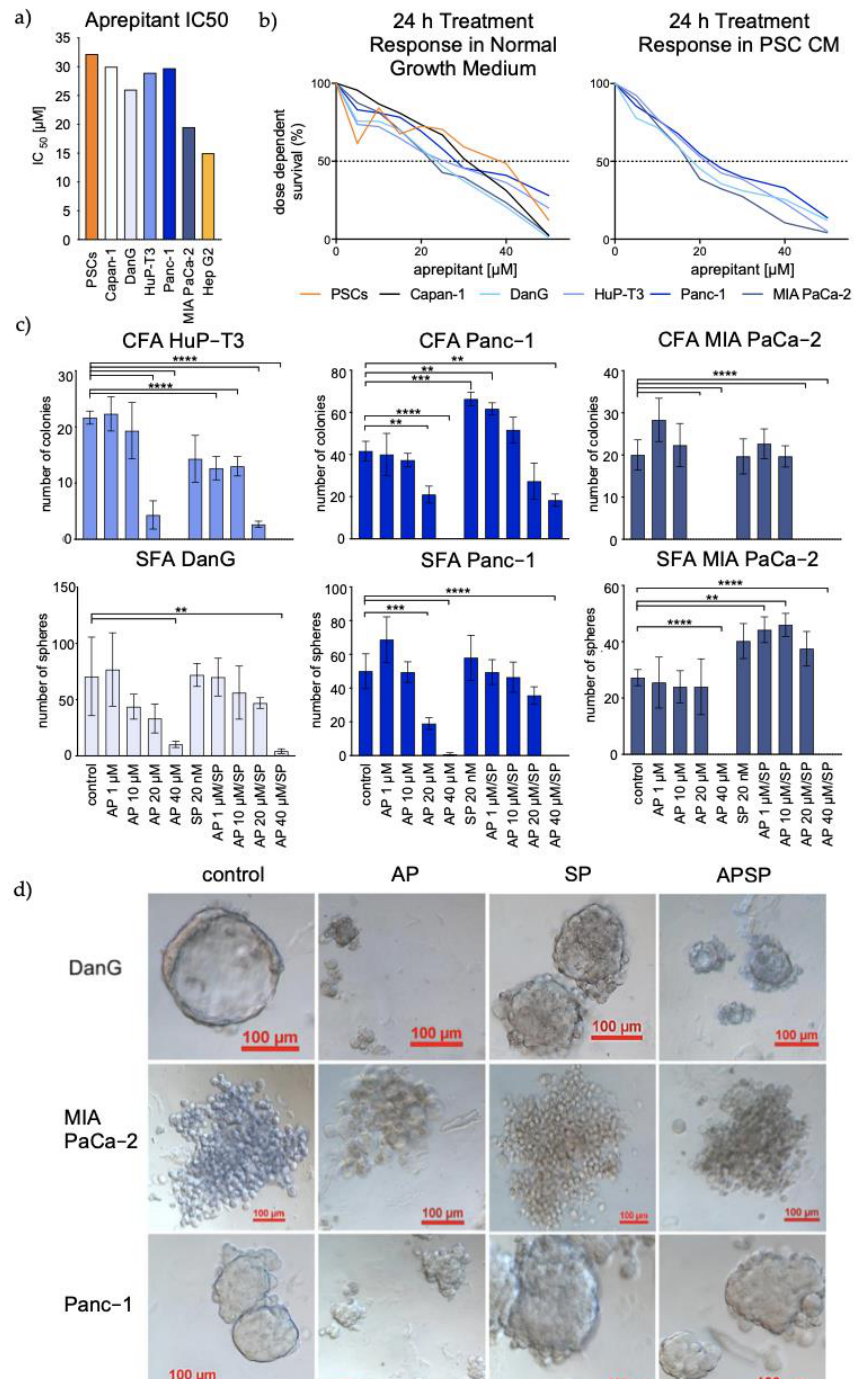
Figure 3. Aprepitant treatment response in PDAC cells, spheres, and colonies. ( a ) IC50 for all tested PDAC cell types as indicated. ( b ) AP dose-dependent survival curves for the indicated PDAC cells in normal (left) or PSC-conditioned media (right). ( c ) Bar charts illustrating number of colonies (upper panel) or spheroids (lower panel) under different treatment conditions as specified on the x-axis. ( d ) Images of SFA under treatment conditions showing morphological changes in the cell lines DanG (upper panel), MIA PaCa-2 (middle panel), and Panc-1 (lower panel).